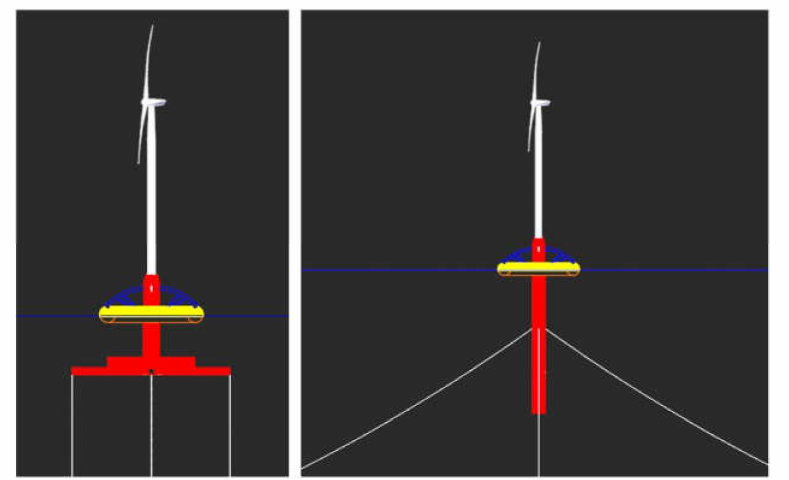
Figure 1. Conceived hybrid wind-wave energy system (HWWES): Wave energy converter (WEC) coupled with the TLP type platform ( left ); WEC coupled with SB type platform ( right